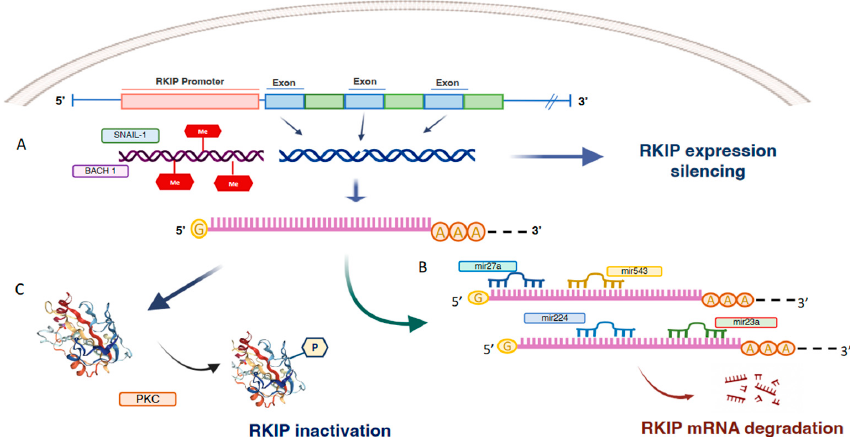
Figure 2. Transcriptional, post-transcriptional and post-translational mechanisms of RKIP inactivation. Schematic representation of the main regulatory mechanisms of RKIP. At transcriptional level, RKIP expression is inhibited by promoter hypermethylation and the binding of inhibitory transcription factors such as SNAIL-1 and BACH1 ( A ). Furthermore, in many cancer types RKIP mRNA is targeted by a number of micro RNAs that act as inhibitors of RKIP expression ( B ). Finally, post- translational regulation of RKIP implies RKIP phosphorylation by PKC that makes it inactive ( C ).